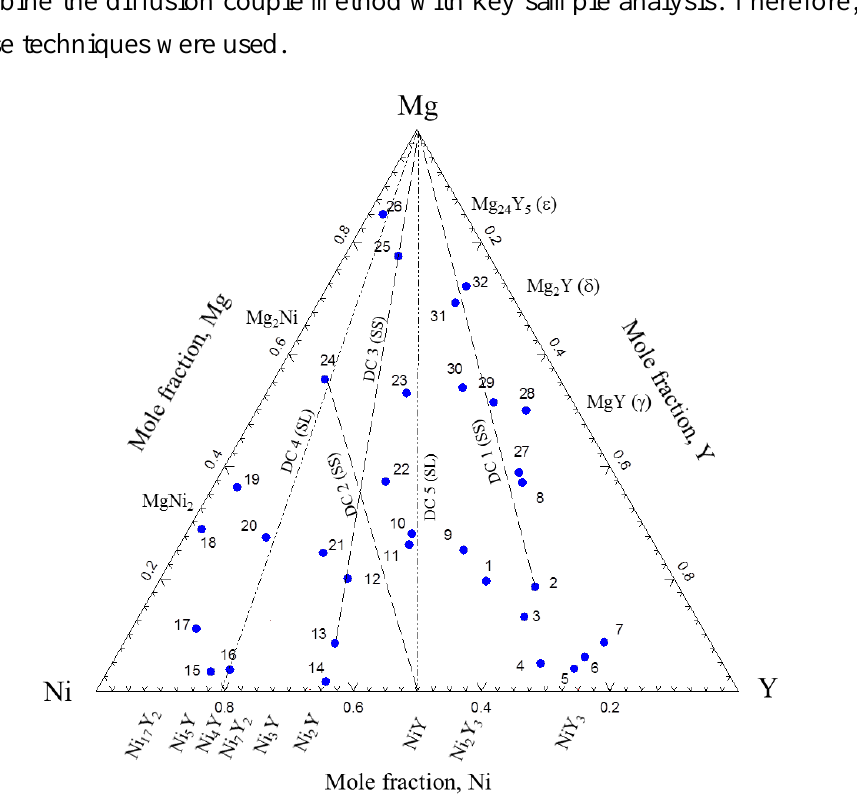
Figure 2. Actual global composition of the Mg-Ni-Y alloys. Dotted lines show the diffusion couples. SS and SL refer to the solid-solid and solid-liquid diffusion